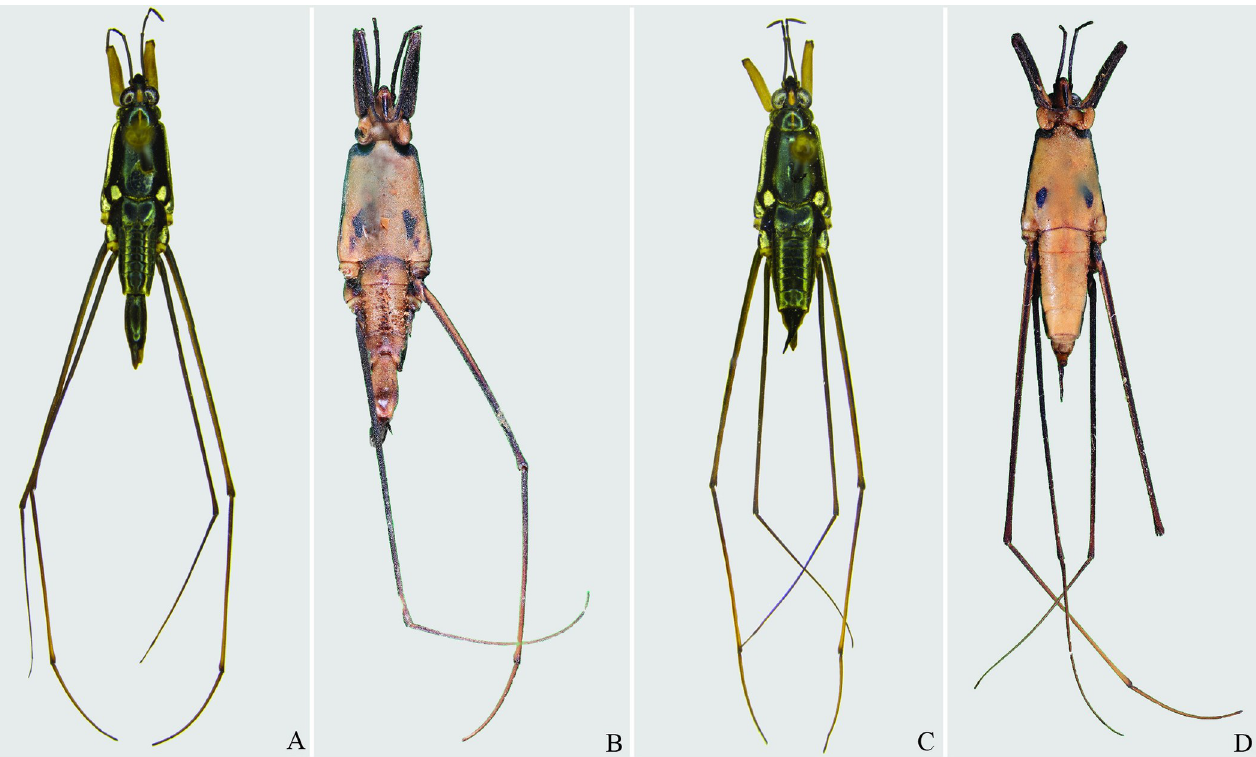
Fig 22. Potamobates osborni . (A) Male, dorsal view; (B) male, ventral view; (C) female, dorsal view; (D) female, ventral view. hind coxae yellowish; middle and hind trochanters blackish; middle and hind femora entirely blackish or with venter yellowish; apices of middle and hind tibia, and entire middle and hind tarsi brown. Metanotum without stripes, posterior margin with golden setae; metacetabulum with stripe of golden setae laterally. Abdomen : medio- and laterotergites I–VII black, lateral margins of mediotergites with longitudinal stripe of golden setae; side of abdomen black, dor- sally with longitudinal stripe of golden setae. Male : sides of abdominal sterna II–IV conspicu- ously longitudinally depressed; sternum VII posteriorly with a shallow, weak depression; VIII conspicuously longitudinally depressed. Abdominal mediotergite VII with posterior margin rounded. Posterior projection of last abdominal laterotergite (= connexival spine) with apex rounded. Abdominal sternum VII with oval notch on posterior margin, twice as wide as long (Fig 2A). Abdominal segment VIII tubular, 1.6–1.7 times longer than wide; lateral margins slightly convergent anteriorly and posteriorly; posterodorsal margin rounded; venter without depression; posteroventral margin rounded, with conspicuous projection on the left, the pro- jection with pair of small teeth (Fig 2A). Pygophore and proctiger sinistrally rotated about 20˚ (Fig 2A and 2B). Pygophore 1.9 times longer than abdominal segment VII. Proctiger 1.5 times longer than abdominal segment VII; anterior margin with short notch, which has about 1/5 of proctiger length; right margin folded ventrally; left margin folded on basolateral process and part of proctiger; apex with many black denticles; right basolateral process developed, triangu- lar, about as long as wide; left basolateral process 5 times longer than wide, with about 2/5 of proctiger length, longitudinal axis about 45˚ divergent from longitudinal axis of proctiger, lat- eral margins slightly tapering, apex not bifid (Fig 2F). Phallus short, smallest width about 3.8 times length (Fig 2C); dorsal sclerite slightly longer and narrower than ventral sclerite, with